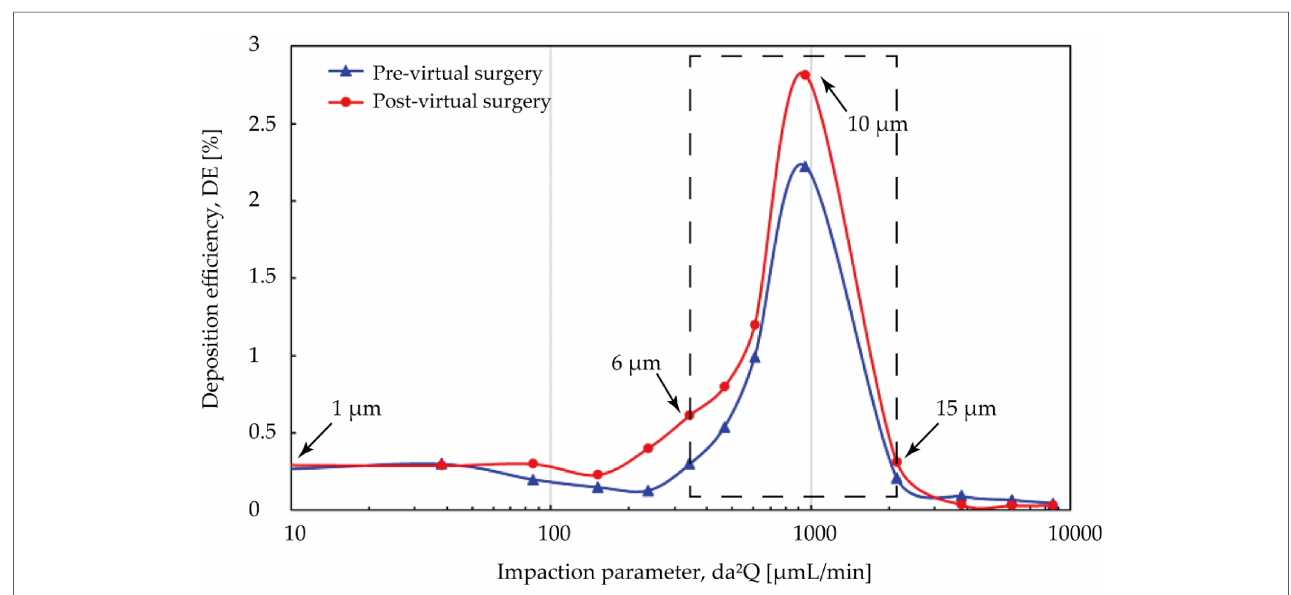
FIGURE 13 Comparison of regional deposition ef fi ciency in adenoid hypertrophy area [%] for pre- and post-surgery case vs. impact factor under inhalation fl ow rate of 9.5 L/min. High deposition ef fi ciency range at 6 μ m and 15 μ m are marked with black